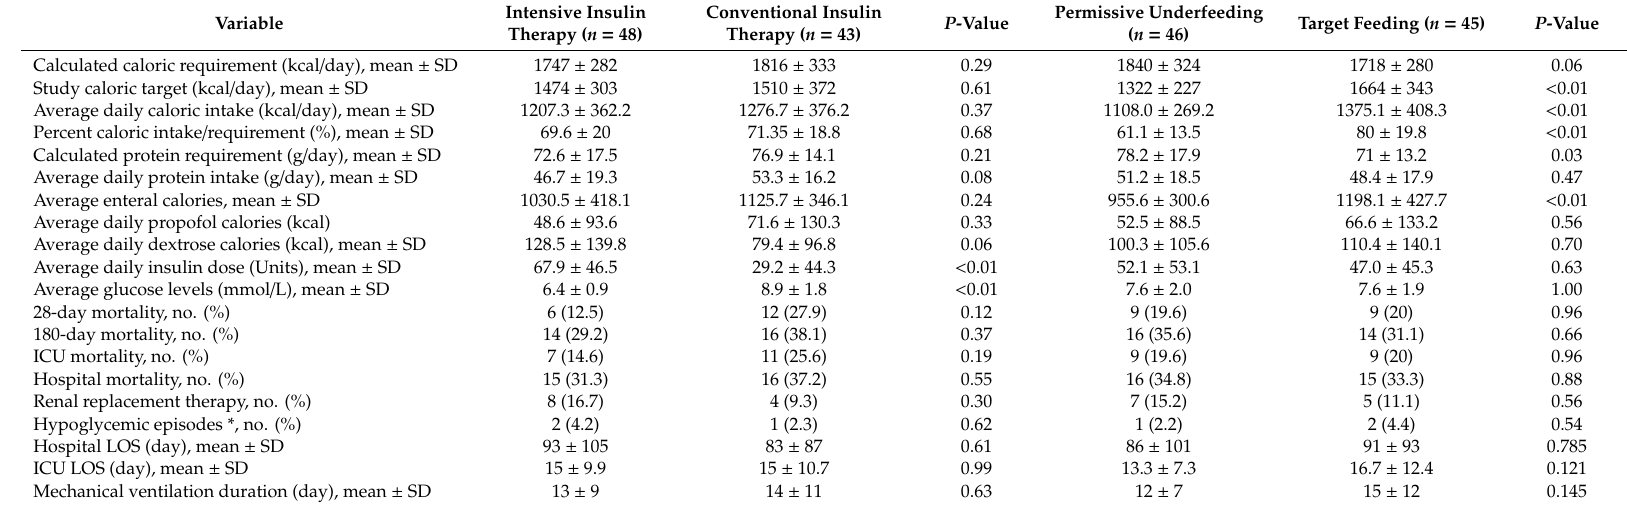
Table 2. Caloric intake, protein intake, insulin, and glucose and outcome data in the permissive underfeeding and target feeding groups and in the intensive insulin therapy and the conventional insulin therapy